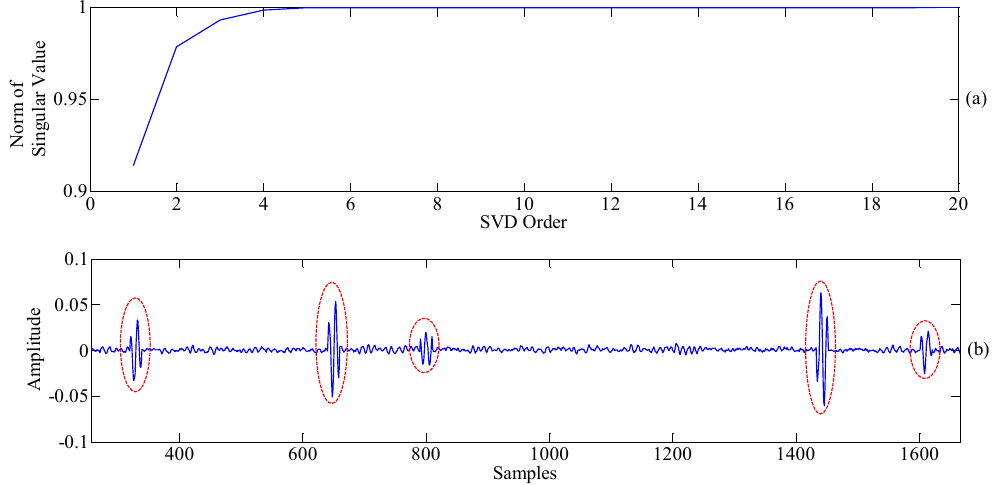
Figure 9. Detection of catastrophe points in signal described by Equation (21). ( a ) Norm of singular value; ( b ) The waveform of P 5 .